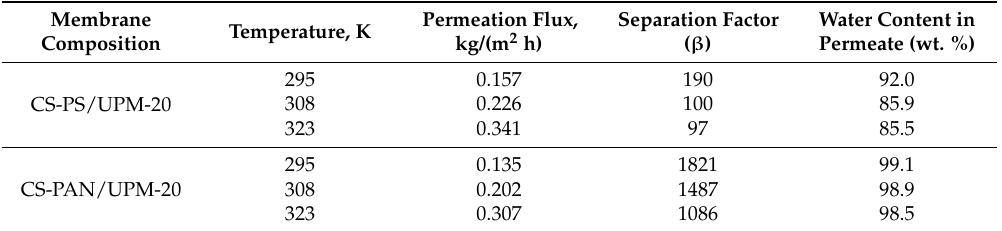
Table 5. Pervaporation results for THF-water mixture (5.7% water) at different